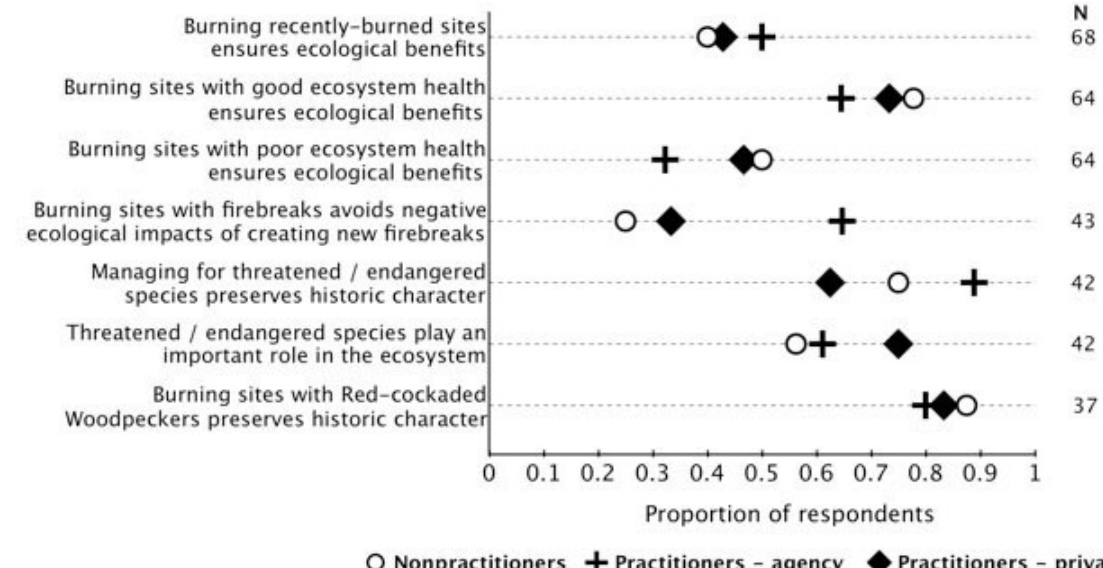
Fig. 4. Proportion of survey respondents in each stakeholder group who agreed with each rationale related to ecological impacts of fire. There were no significant differences among groups for any of these